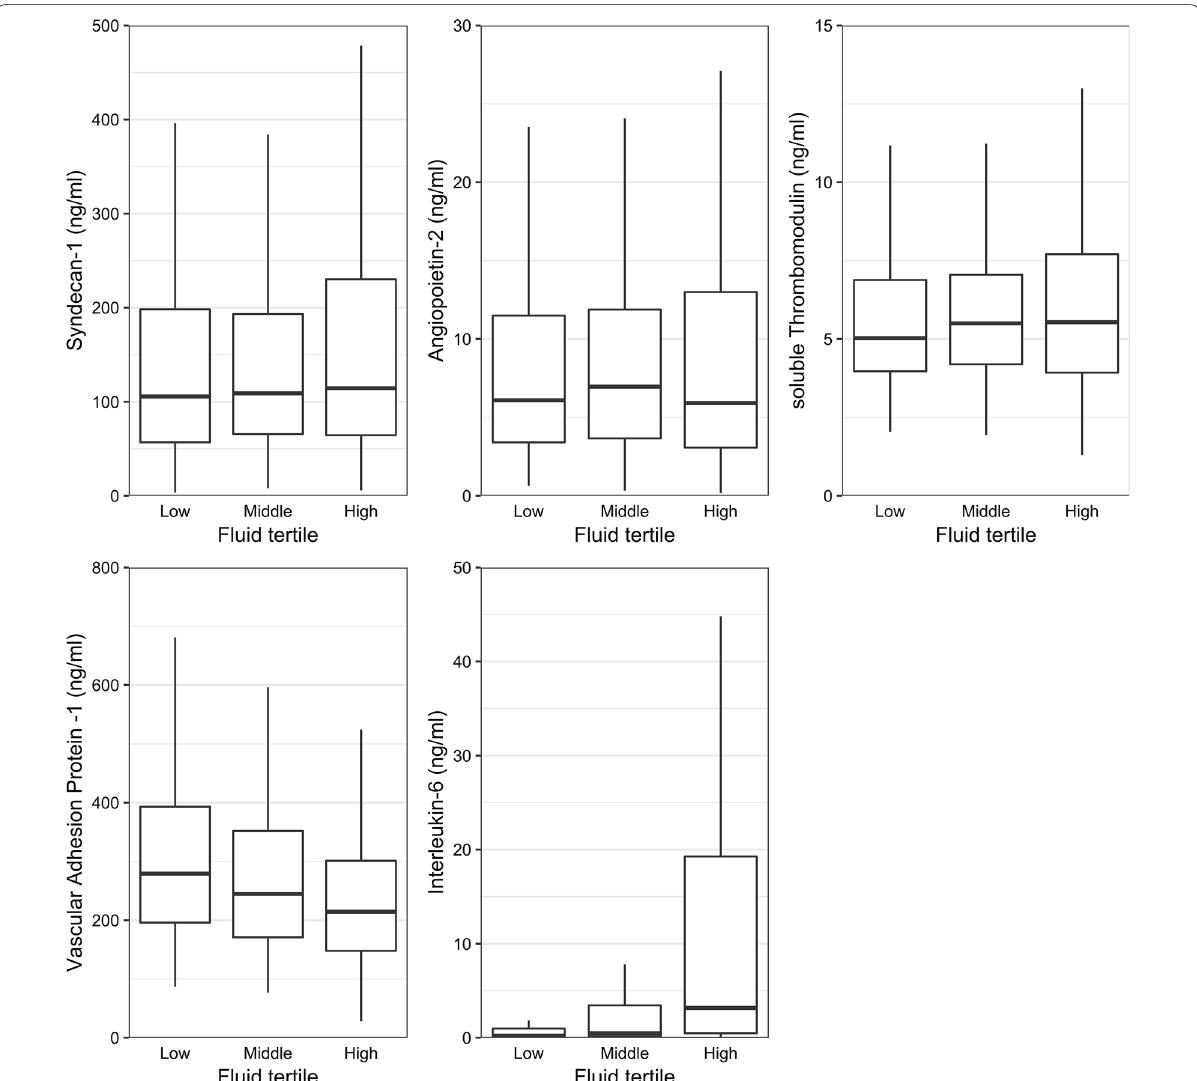
Fig. 1 Biomarker levels at ICU admission according to fluid administration tertiles. Fluid tertile 1: < 201 mL/h. Fluid tertile 2: 202–314 mL/h. Fluid tertile 3: 315–2824 mL/h. Between fluid tertiles 1 and 2 IL‑6 p value < 0.001, all other biomarkers’ p values > 0.010; between fluid tertiles 1 and